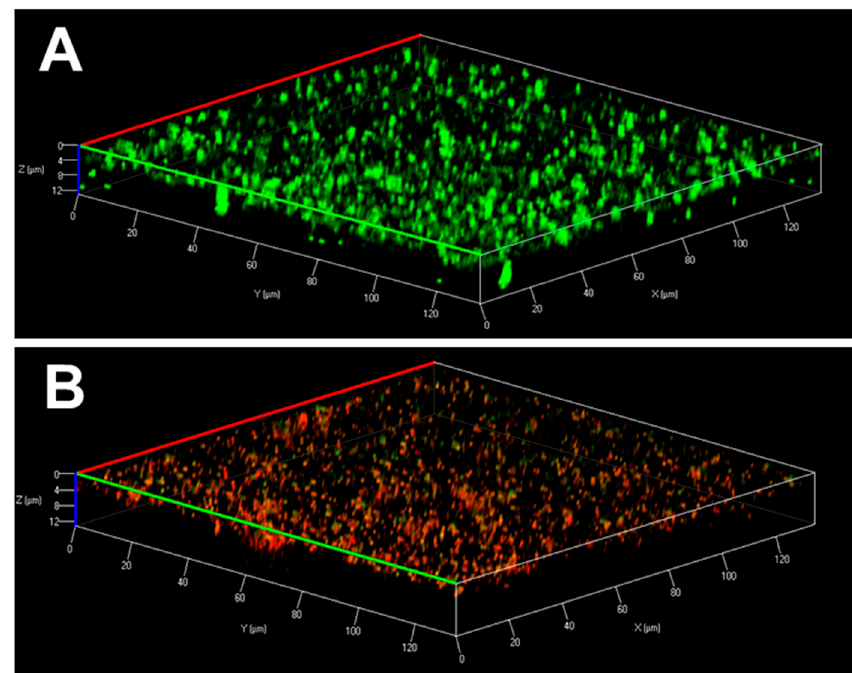
Figure 7. Confocal microscopic images of the 24 h established biofilms of S. aureus USA300 LAC without ( A ) and with peptide treatment ( B ). Biofilms were stained using the live and dead staining kit containing a mixture of 4 ′ ,6-diamidino-2-phenylindole (DAPI, green) and propidium iodide (PI, red). Both dyes bind bacterial DNA, a molecular process that only occurs when bacterial membranes are damaged by the peptide. Bacteria in the untreated control biofilms are green and live ( A ), whereas the bacteria are dead and turned red ( B ) after treatment with WW298 at 12.5 µM.